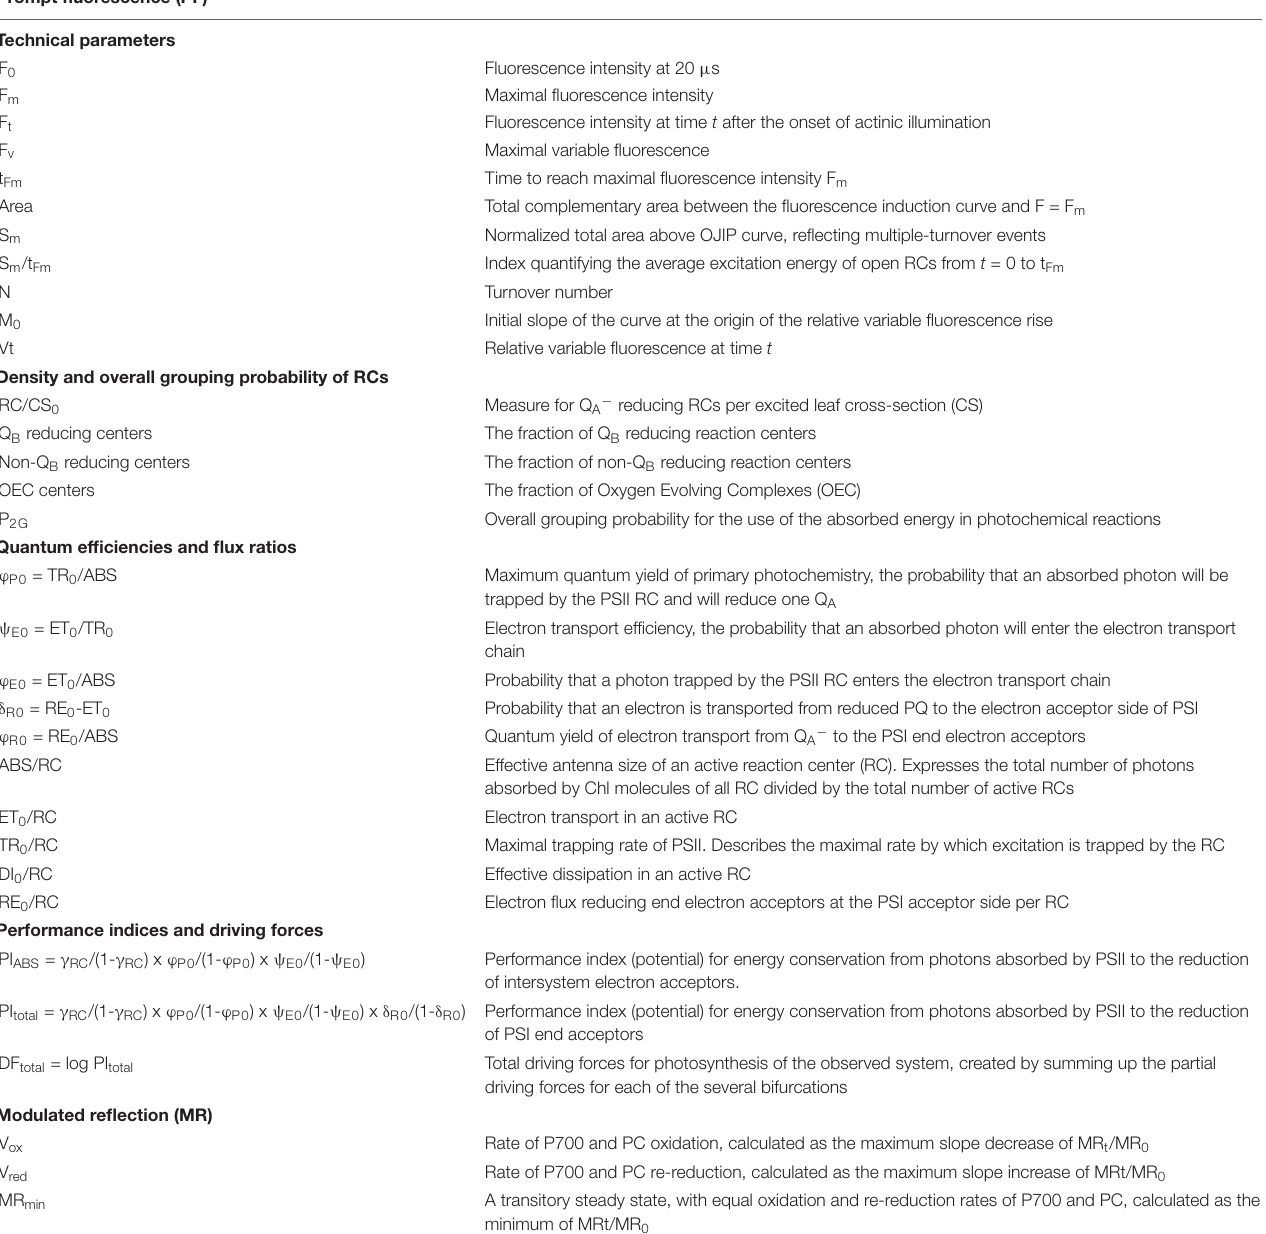
TABLE 1 | Description of used JIP-test